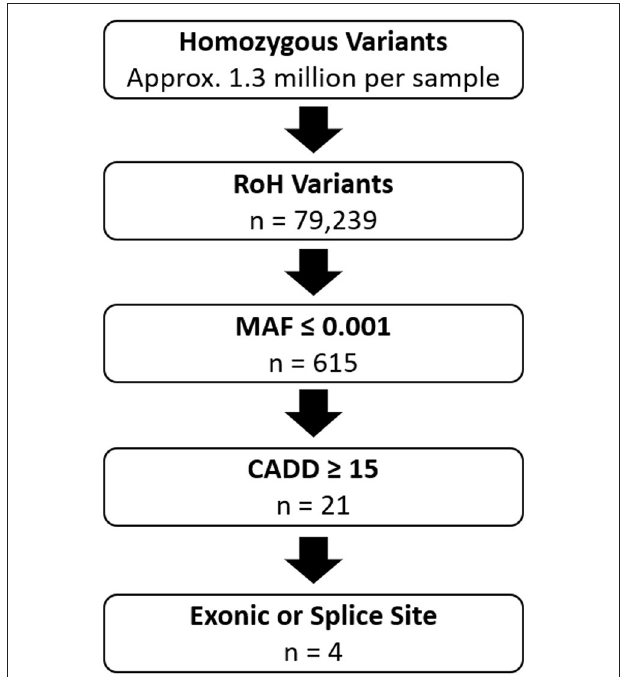
FIGURE 1 | Overview of Variant Filtering in Family 1. RoH Variants: Variants that fall within the 103.8MB of shared homozygous regions between the two affected individuals. MAF ≤ 0.001: Number of variants with minor allele frequency ≤ 0.001 based on data from gnomAD. CADD ≥ 15: Number of variants with CADD scores ≥ 15. Exonic or Splice Site: Number of variants located within exons or splice acceptor or donor sites. n, indicates remaining number of variants after each